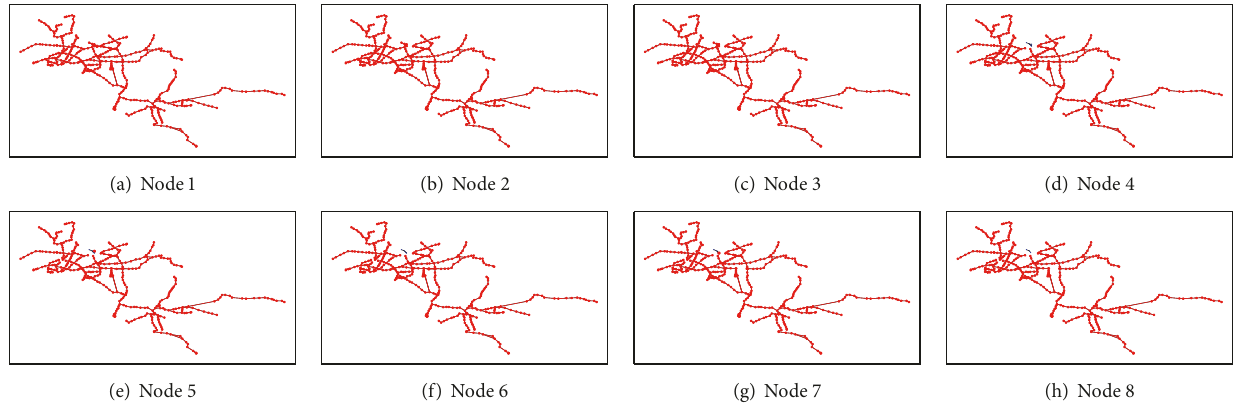
Figure 3: Evolution of an attack generation on the tram network with DEG. The giant component is highlighted in red and bold. When attacking the 8th node, the size of the giant component is hardly